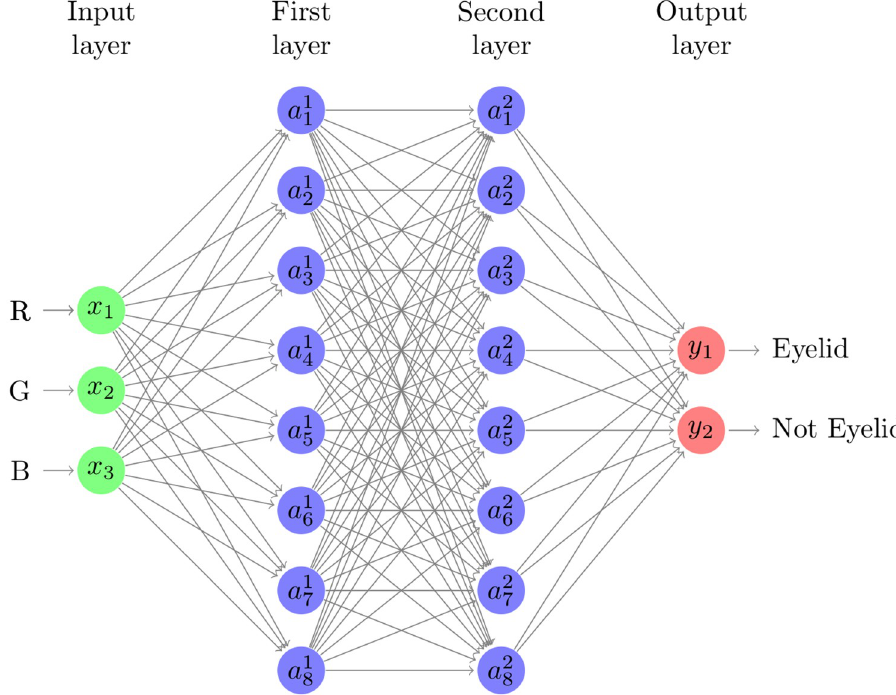
Fig 4. Network architecture of multilayer perceptron-based pixel-level